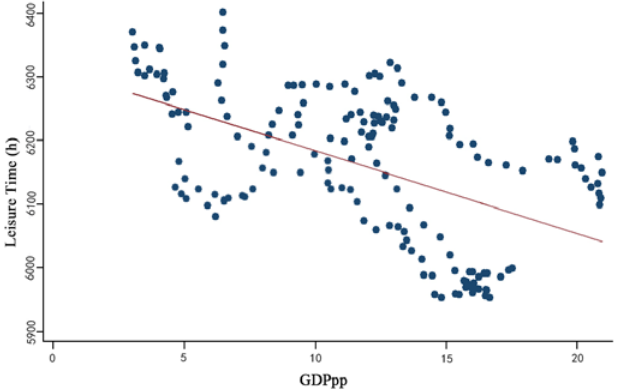
Note: the 16 countries are Luxembourg, Norway, Netherlands, United States, Denmark, Germany, Belgium, Sweden, Canada, Australia, United Kingdom, Finland, Japan, New Zealand, Greece, and Korea Figure 6: The correlation between leisure time and labor production in these 5 countries in 1980–2013